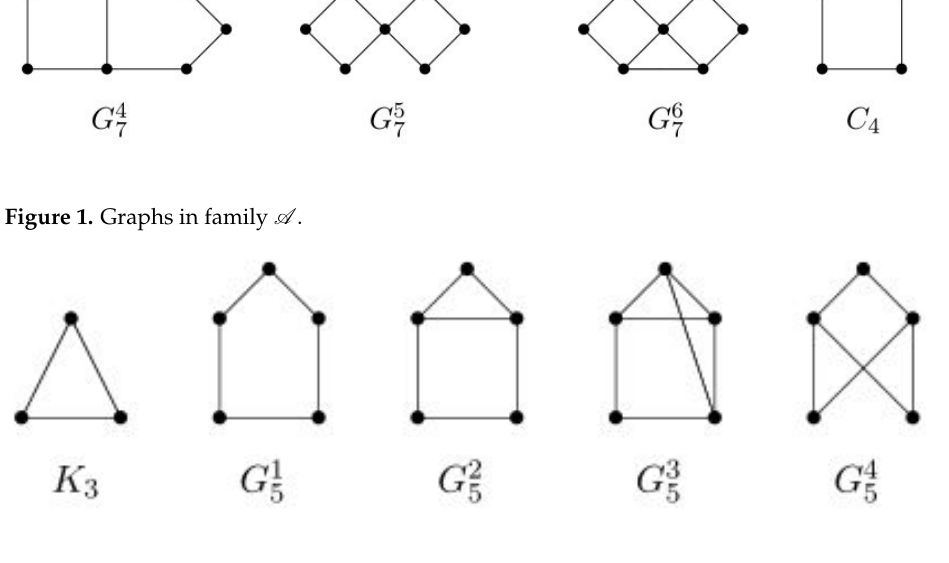
Figure 2. Graphs in family B